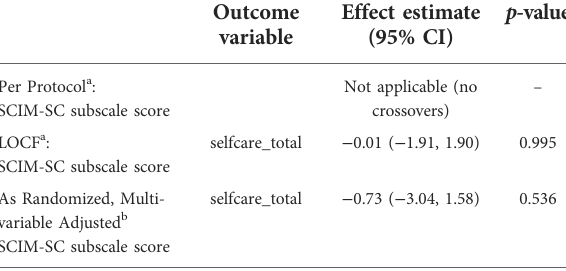
TABLE 10 Sensitivity analyses on the primary outcome.